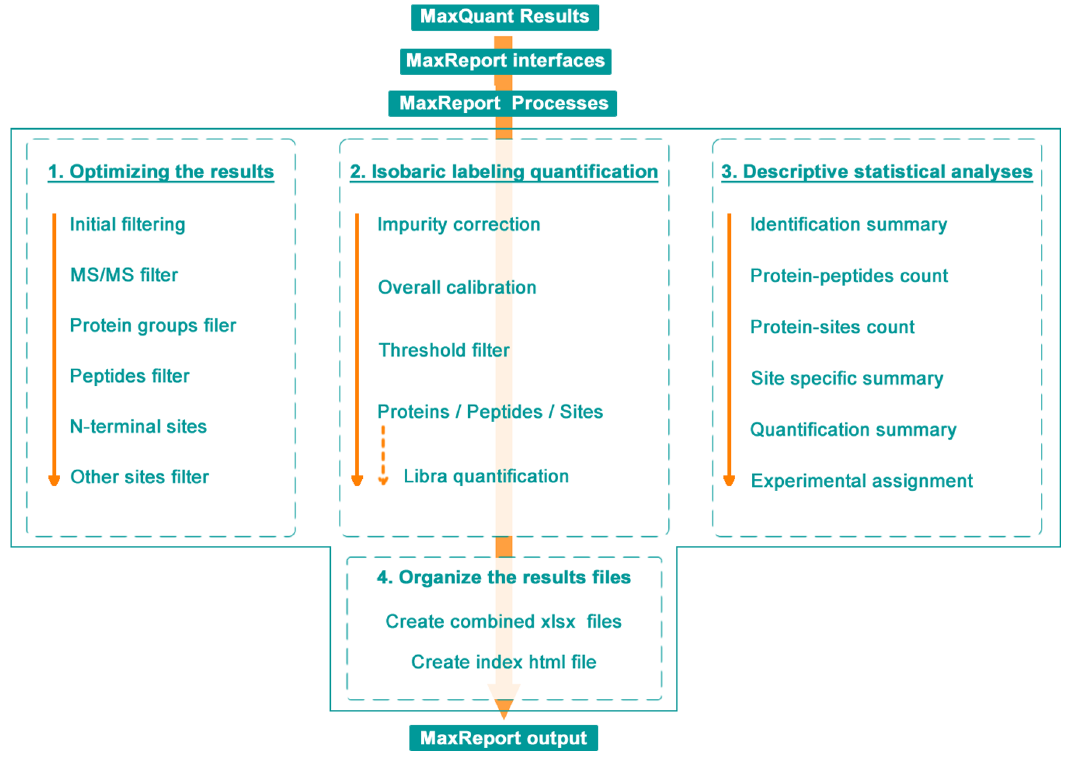
Fig 1. Overview of the MaxReport